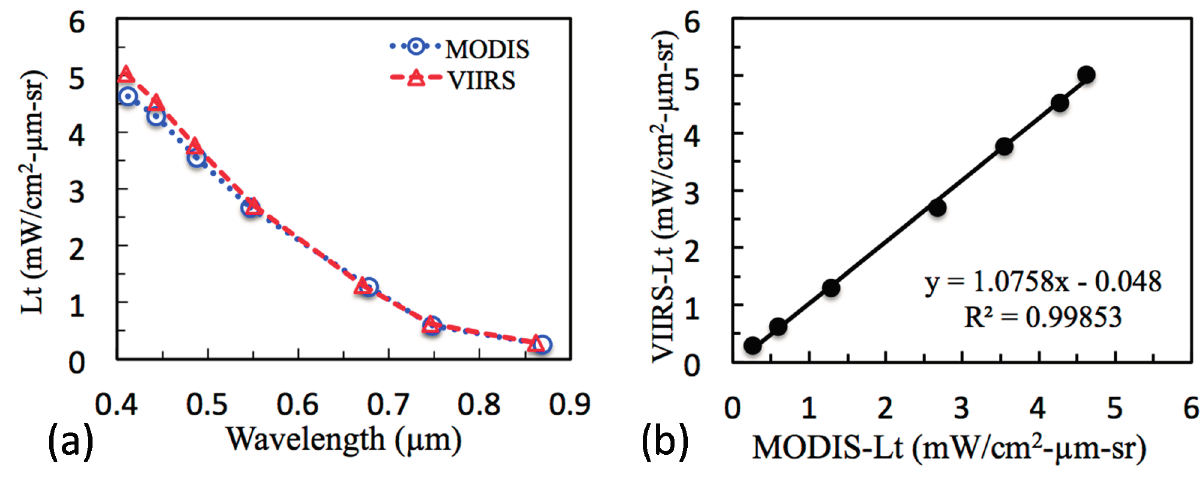
Figure 2. ( a ) Top-of-Atmosphere multi-channel total radiances (Lt) in unit of mW/(cm 2 -µm-sr) of MODIS and VIIRS over Region 2, and ( b ) scatter plot of MODIS versus VIIRS Lt plus the best fit least-square regression line.